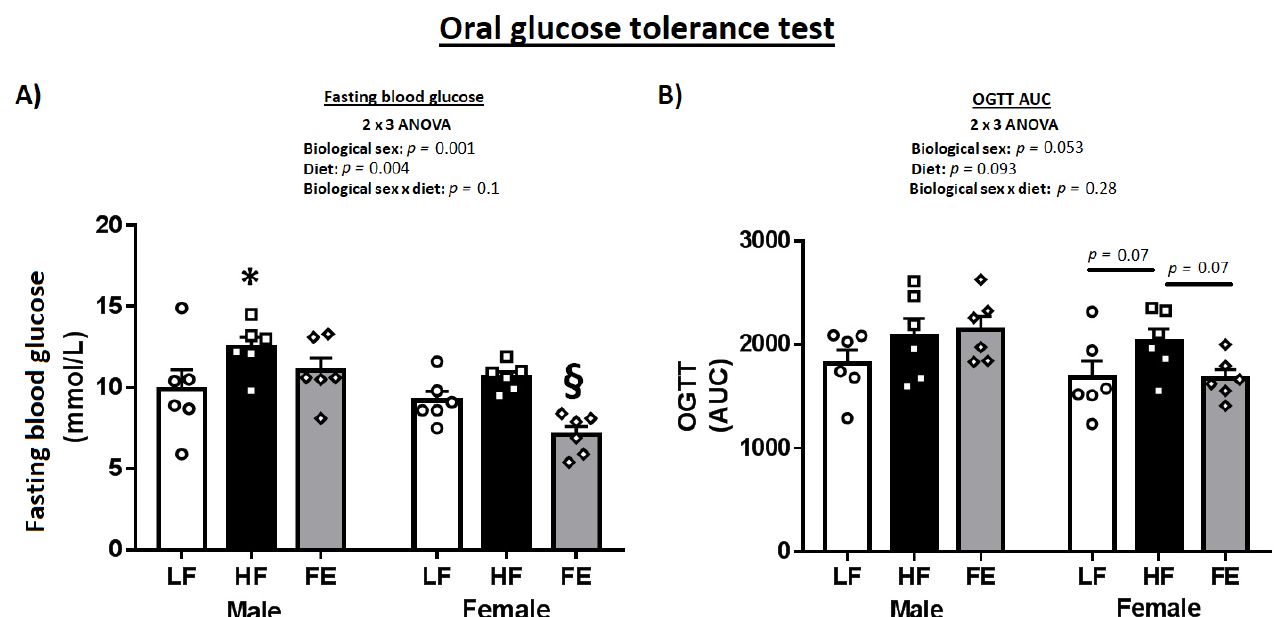
Figure 3. Effects of the ‘Fertility Enhancer’ supplement on fasting blood glucose and oral glucose tolerance test in Western diet-fed C57BL/6J mice. ( A ) Fasting blood glucose. ( B ) Area under the curve (AUC) from oral glucose tolerance test (OGTT) * Significantly different from LF ( p ≤ 0.05). § Significantly different from HF ( p ≤ 0.05).